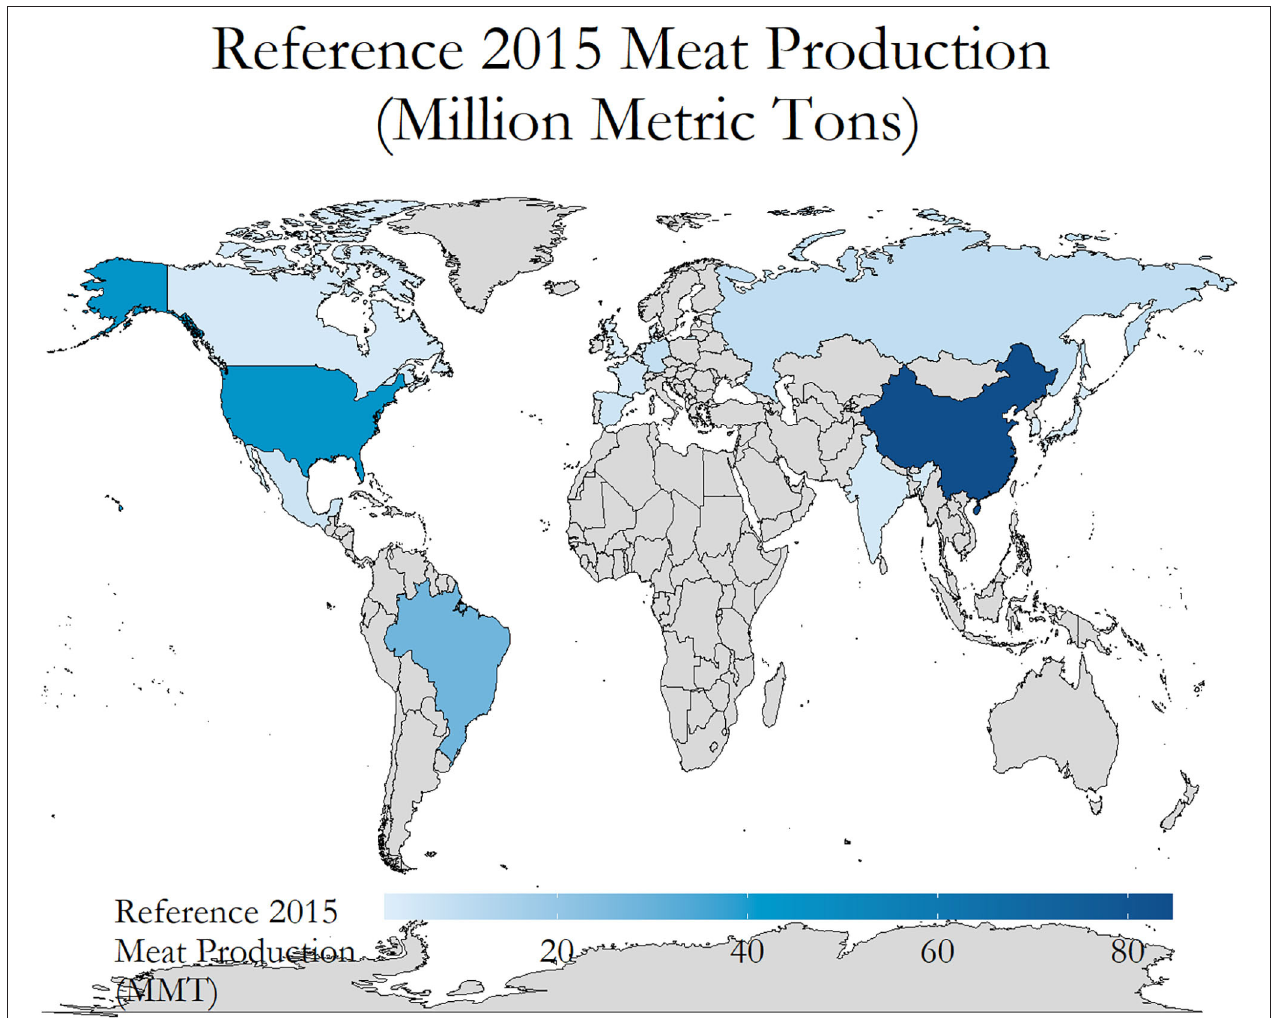
FIGURE 1 | Reference regional livestock production for base year